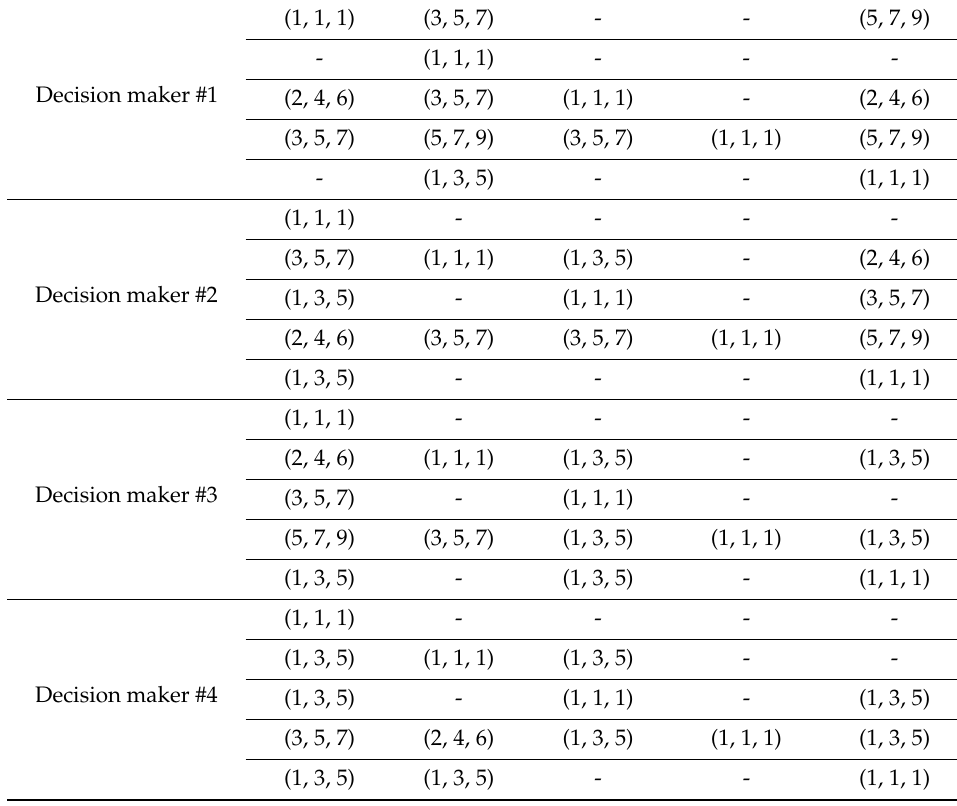
Table 4. Fuzzy pairwise comparison matrixes constructed by four decision